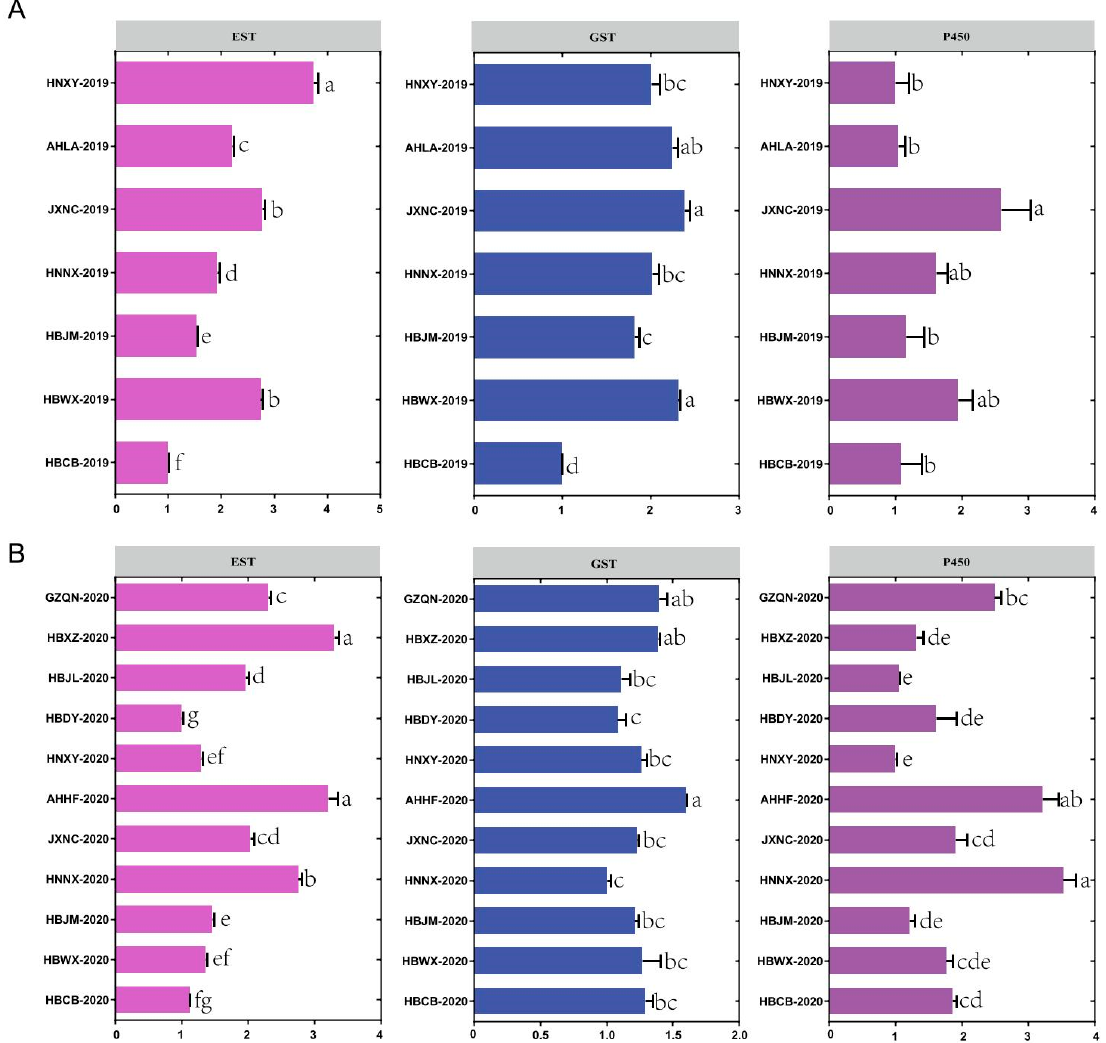
Figure 2. Relative activities of the detoxification enzymes in field populations of S. furcifera in 2019 ( A ) and 2020 ( B ). The relative enzyme activity of the detoxification enzyme corresponds to the ratio of the detoxification enzyme activity and the minimum enzyme activity. The SE bars with different small letters represent significant differences ( p < 0.05).